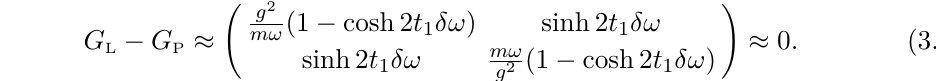
Figure 6 . log ρ and log ρ 0 vs time for the figure on the left. Relative error (log ρ 0 L L vs time for the figure on the right. The parameters is set as δω/ω = 10 − 3